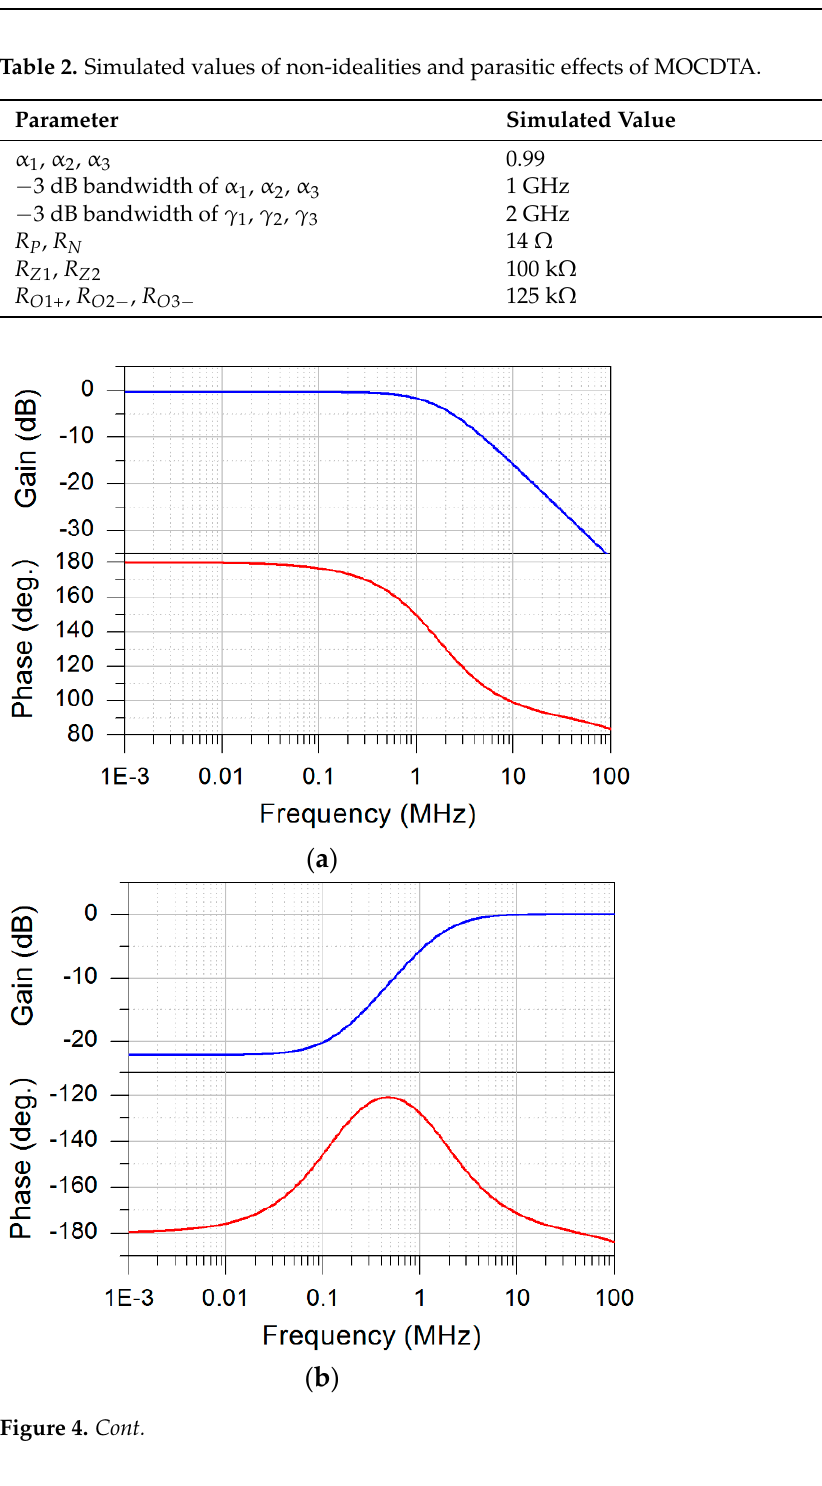
( c ) Figure 4. Frequency responses of gain and phase: ( a ) LP; ( b ) HP; ( c ) AP.